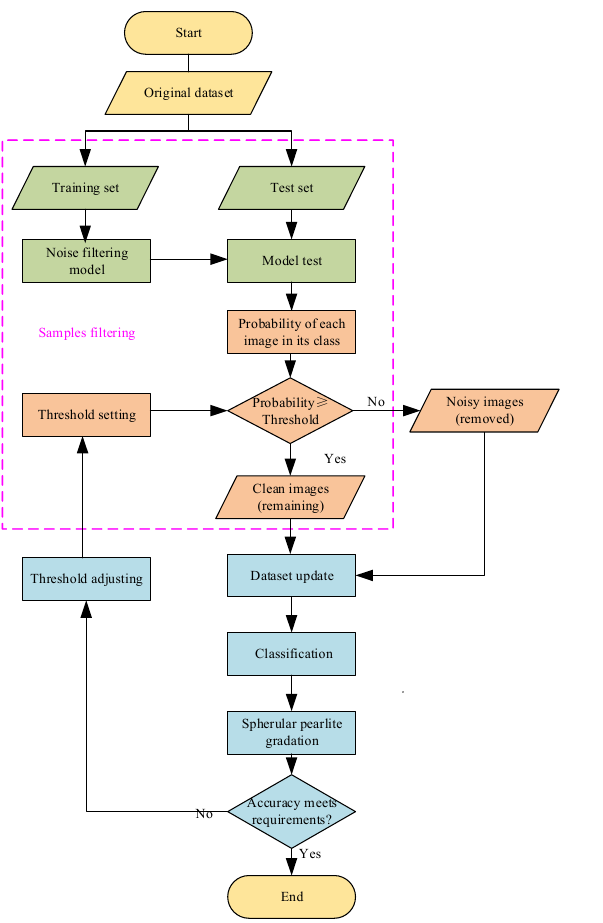
Figure 2. Process flowchart for the proposed method.